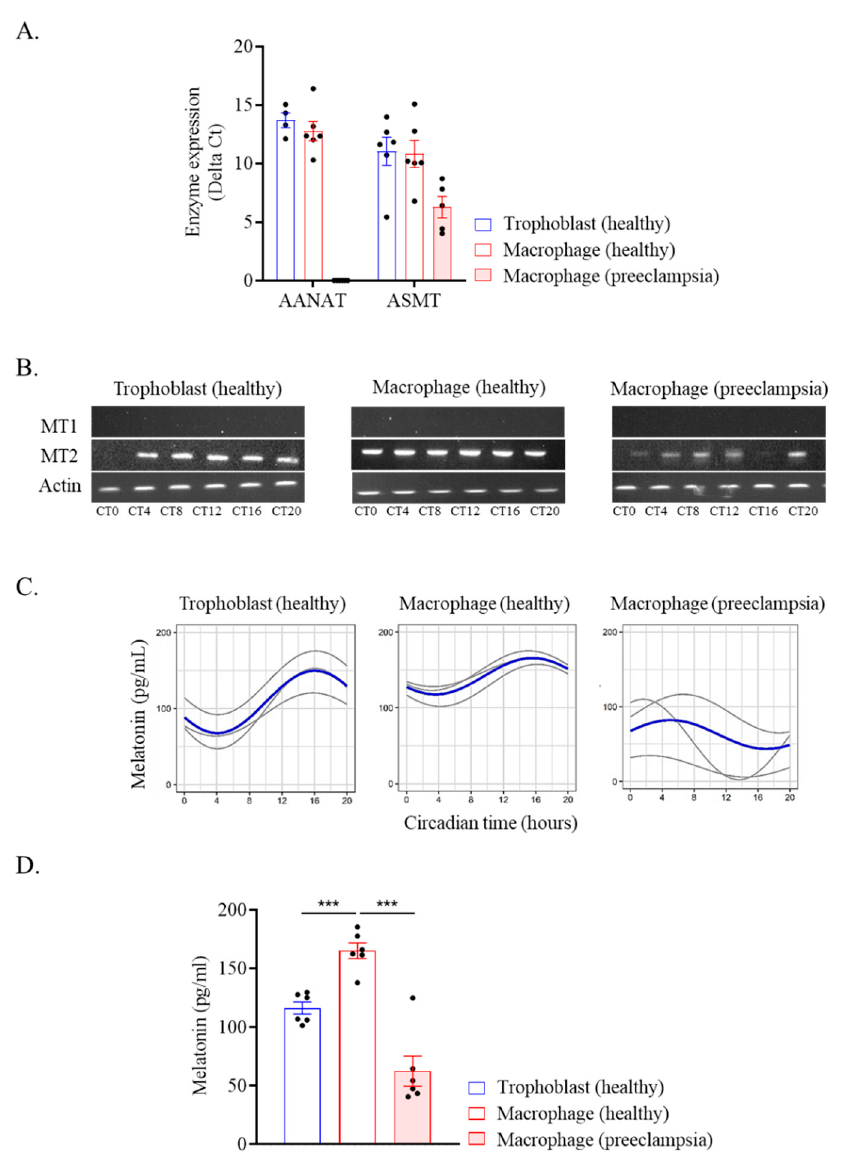
Figure 4. Melatonin from placental cells. Trophoblasts and macrophages were isolated from healthy and preeclamptic placentas. ( A ) The expression of AANAT and ASMT enzymes was evaluated by qRT-PCR every 4 h for 24 h and expressed in delta Ct (in technical triplicate for each donor and time). The average of enzymatic expression or each donor investigated was illustrated for trophoblast ( n = 6), macrophage ( n = 6), and preeclamptic macrophage ( n = 5) (mean ± SEM). ( B ) The expression of the melatonin receptor MT1 and MT2 was evaluated by qRT-PCR every 4 h for 24 h and a migration was performed after gene amplification. ( C , D ) Melatonin level was quantified in the cell culture supernatant every 4 h for 24 h and expressed in pg/mL. ( C ) The circadian rhythmicity of the melatonin level was evaluated for 3 donors (with 3 technical replicates). Sinusoids in gray represent each investigated donor and the mean of biological replicates is represented in blue. The statistical analysis was performed using the cosinor function using R studio (v3.4.0, Boston, USA). ( D ) The mean of melatonin production over 24 h was evaluated for 6 donors (3 technical replicates mean ± SEM). *** p < 0.001.